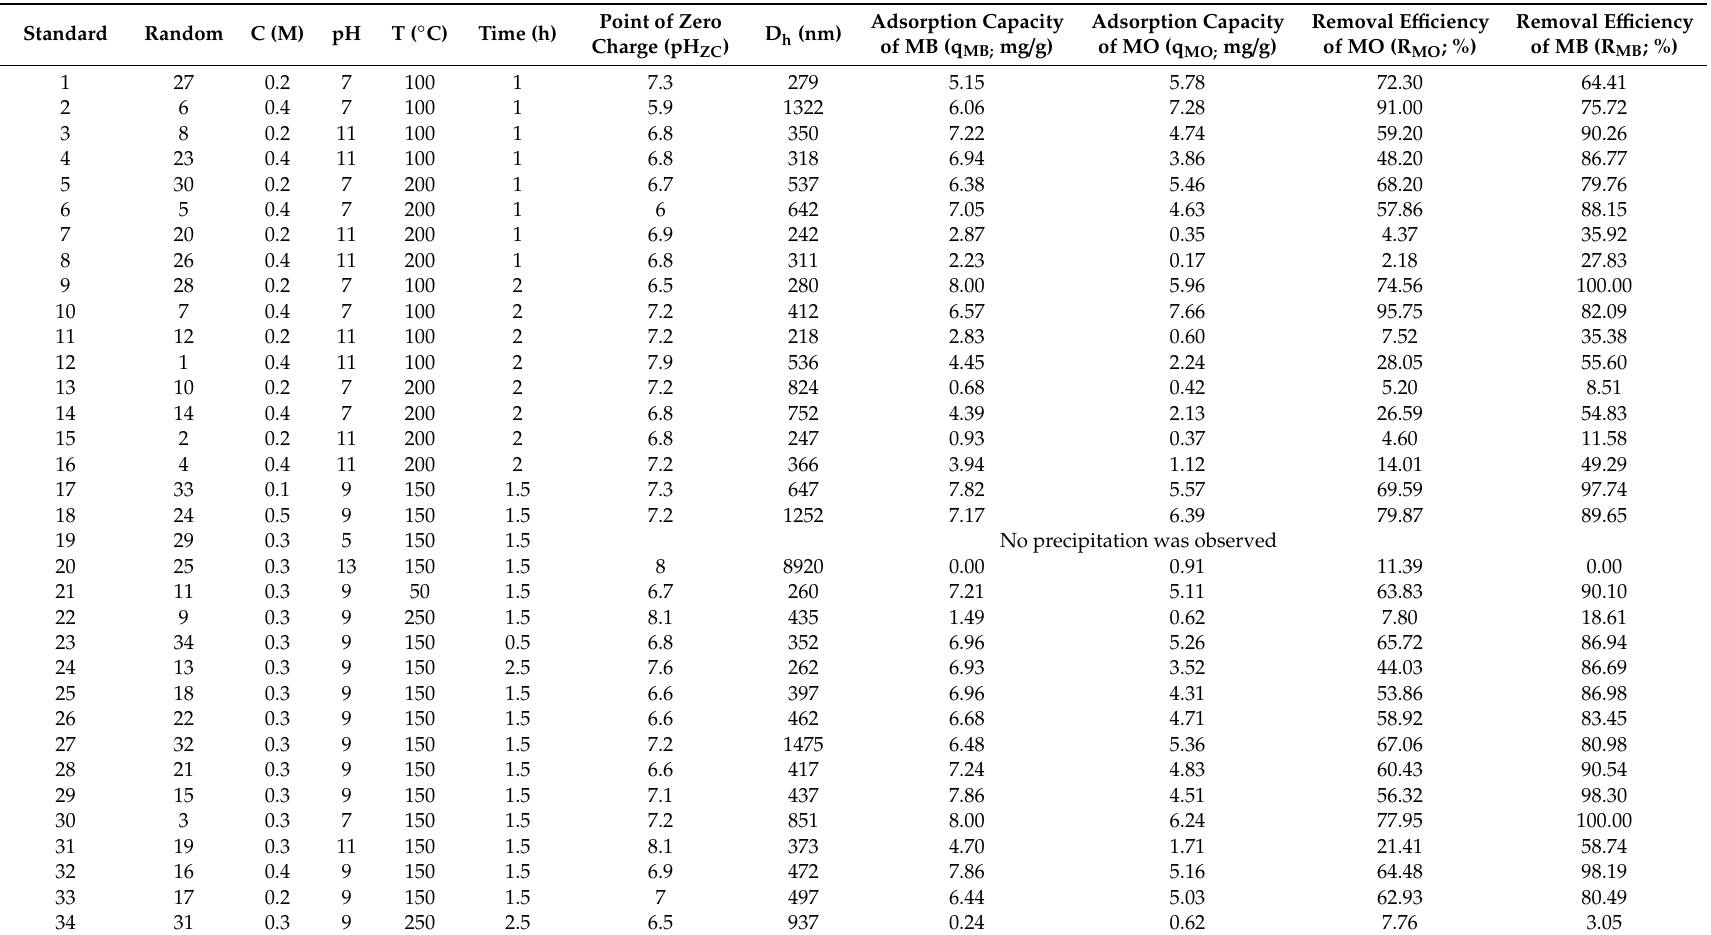
Table 2. Independent variables and their real values and responses